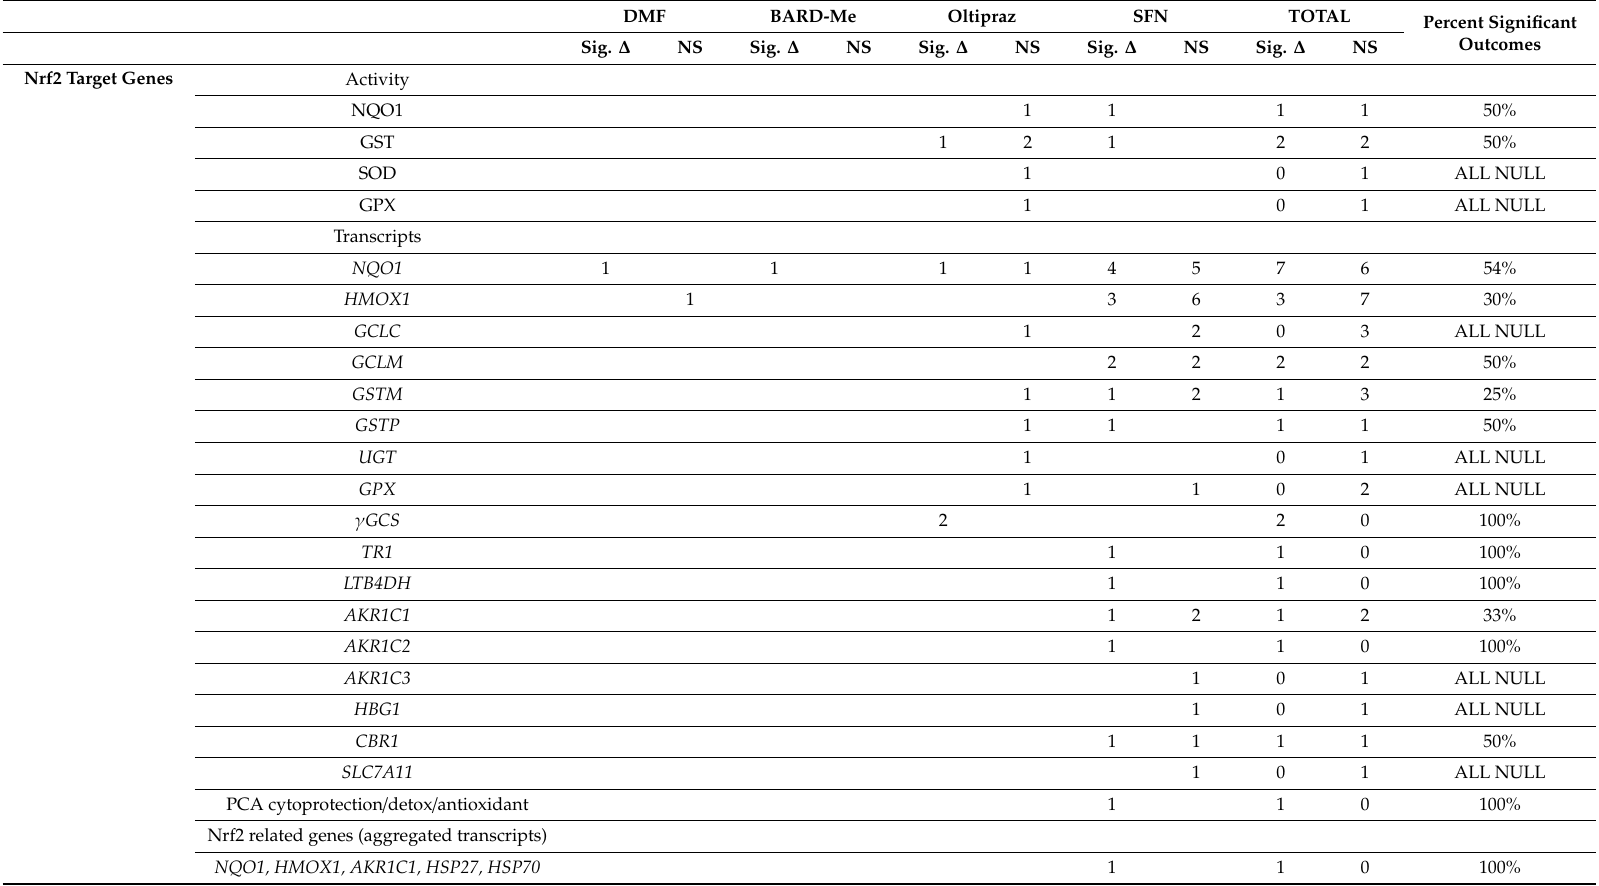
Table 1. Significant vs. null (nonsignificant) outcomes of individual biomarker